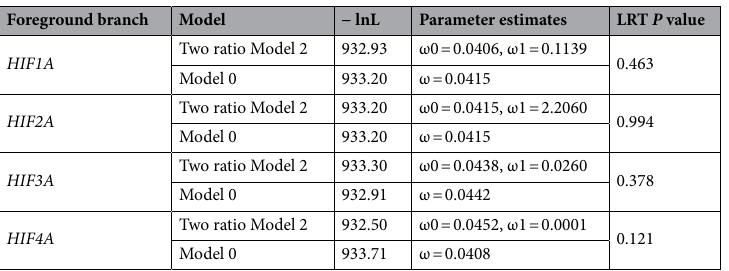
Table 2. Summary of EasyCodeML branch model analyses for detecting variable selective pressures among HIFA genes. The two-ratio Model 2 allowed the ratio of non-synonymous to synonymous substitutions (ω) in the indicated HIFA gene to differ from ω for other HIFA genes. Model 0 assumed a constant ω for all HIFA genes. For each HIFA gene, the difference in likelihood of the two models was evaluated with likelihood-ratio tests